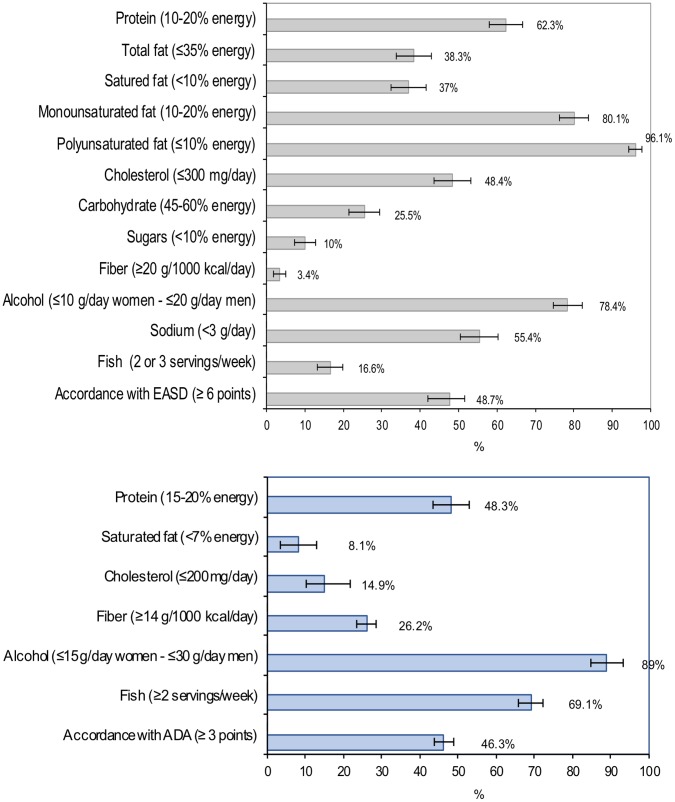
Accordance with nutrient recommendations of EASD and ADA.Percentage of diagnosed diabetic subjects who achieved each nutrient recommendation of the EASD (figure a) and ADA (figure b) and accordance with EASD (figure a) and ADA (figure b). Bars represent 95% confidence intervals.